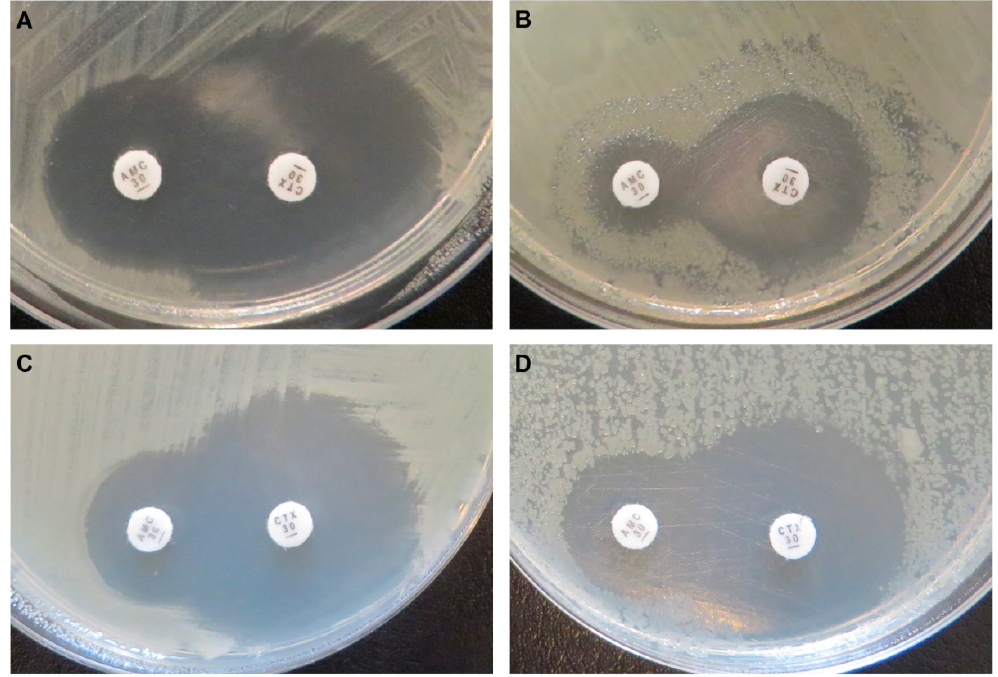
Figure 2. Disk diffusion tests. E. coli C600Z1 pZE21- bla IDC-1 with expression not induced ( A )